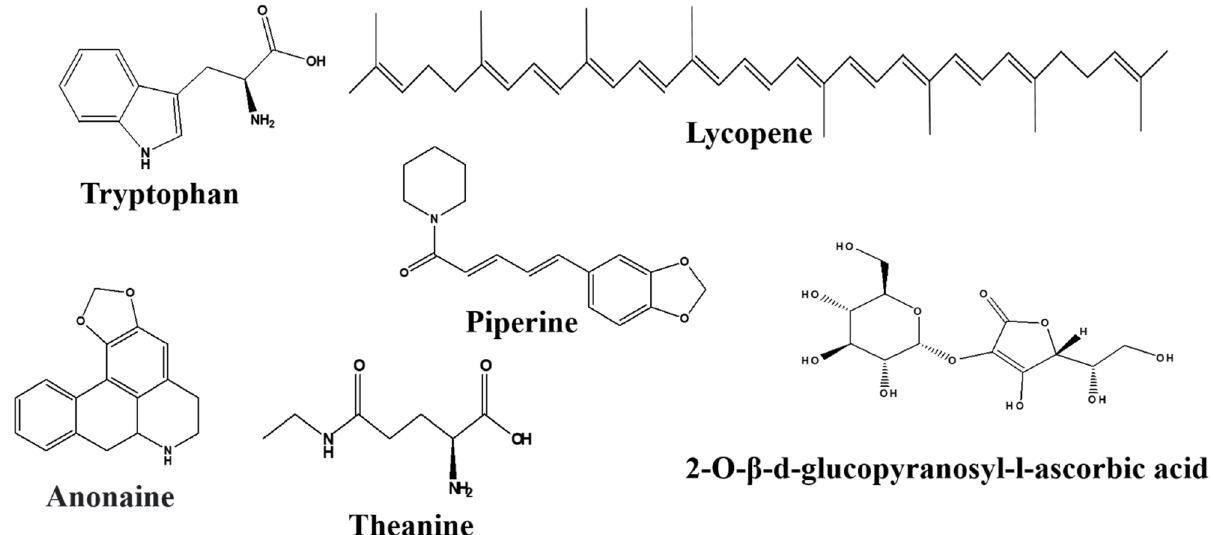
Figure 3. Structures of bioactive metabolites from natural products: Tryptophan—human breast milk, Moringa oleifera , and Nelumbo nucifera ; theanine— Camellia sinensis ; anonaine— Annona muricata ; piperine— Piper nigrum ; lycopene— Citrullus lanatus ; 2-O- β -d-glucopyranosyl-l-ascorbic acid— Lycium barbarum .